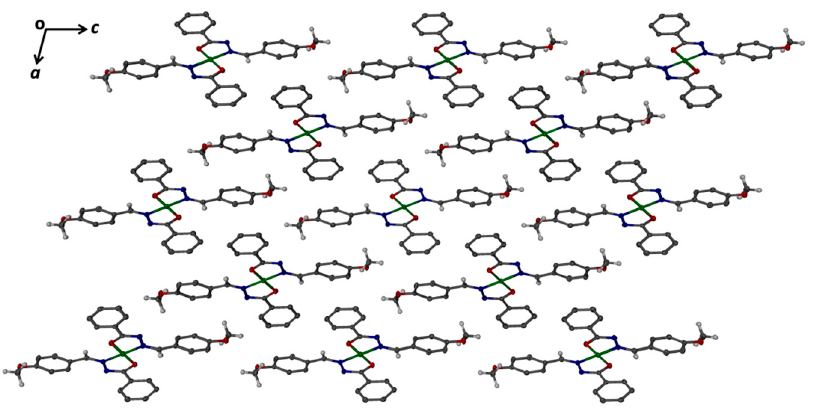
Figure 9. View showing the arrangement of discrete units of the Ni(II)-2L along ac -plane. Aromatic hydrogen atoms are removed for clarity. Table 6. Selected bond length (Å) and bond angles (°) for Ni(II)-2L.